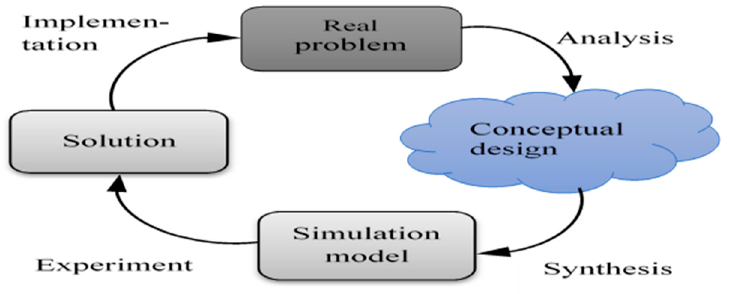
Figure 1. The main phases of proposed methodology [5]